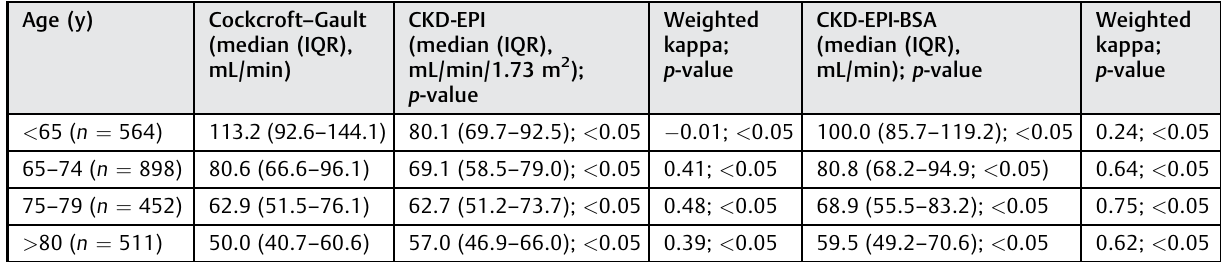
Abbreviations: CKD-EPI, chronic kidney disease epidemiology initiative equation; CKD-EPI-BSA, chronic kidney disease epidemiology initiative equation adjusted for body surface